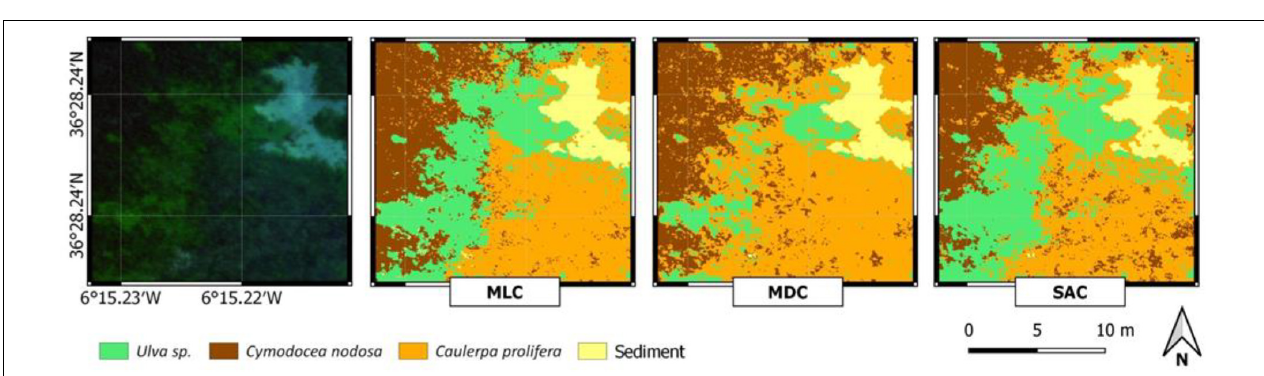
FIGURE 8 | Zoom of the study area where the following species can be visually identified: Ulva sp., C. nodosa , and C. prolifera . A comparison is made between the results obtained by applying the MLC, MDC, and SAC algorithms to make the supervised